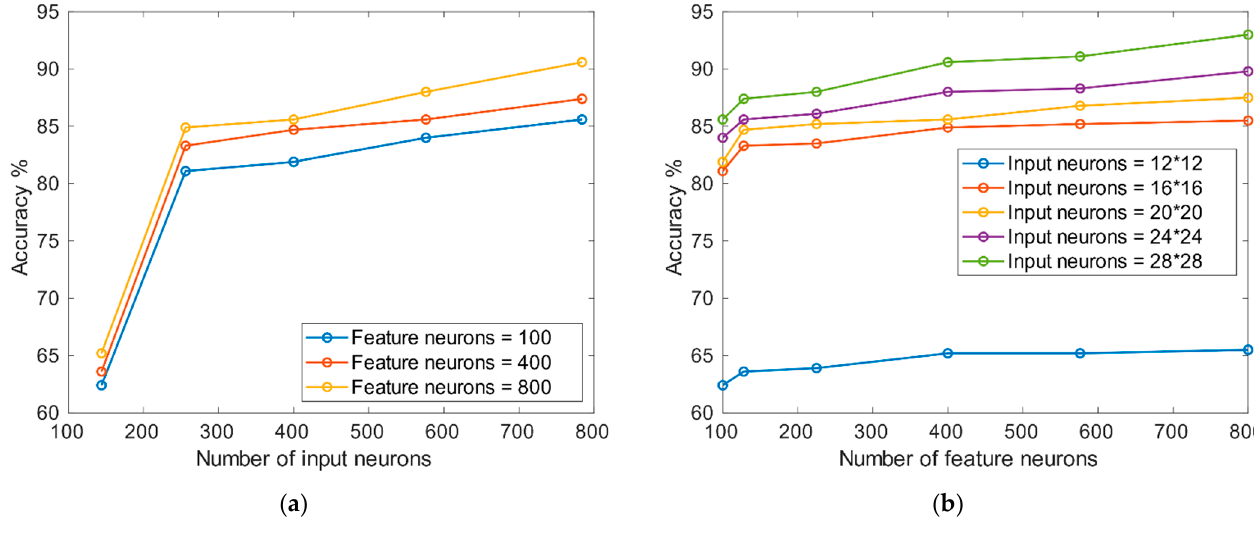
Figure 5. (a) Accuracy vs. number of input layer neurons; (b) accuracy vs. number of feature layer Figure 5. ( a ) Accuracy vs. number of input layer neurons; ( b ) accuracy vs. number of feature layer neurons.